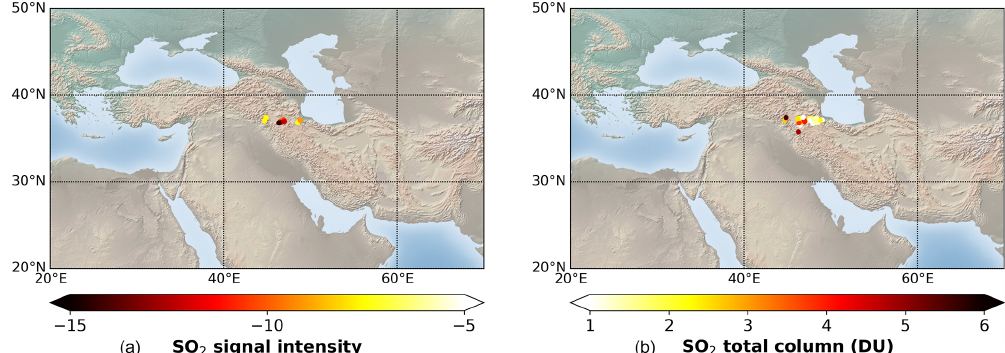
Figure 14. Analysis of sulfur plant fire event in Iraq on 24 October 2016 in the evening (nighttime or PM orbit) based on IASI/Metop-A L1C data. (a) Spatial distribution of residual values associated with SO 2 . (b) SO 2 total column in Dobson